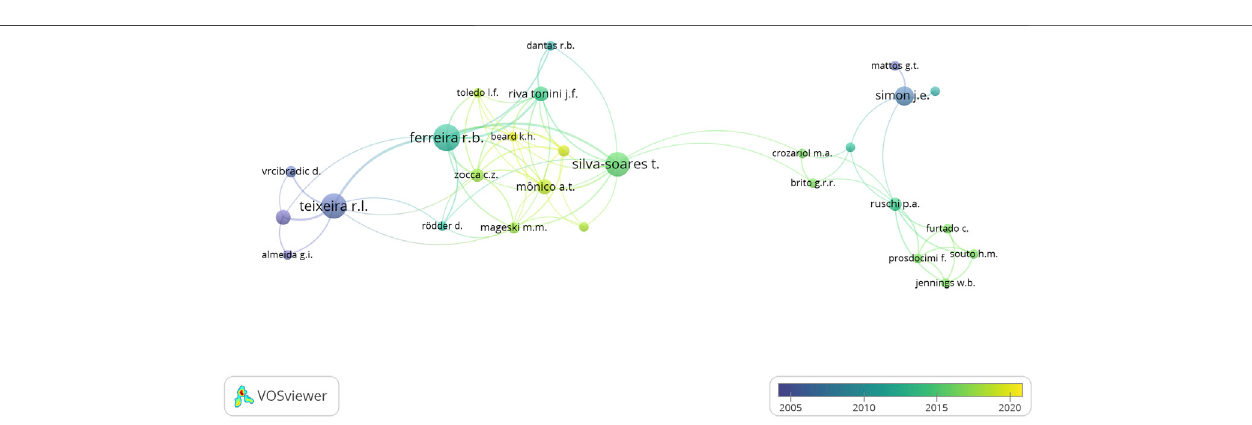
Frontiers in Research Metrics and Analytics |